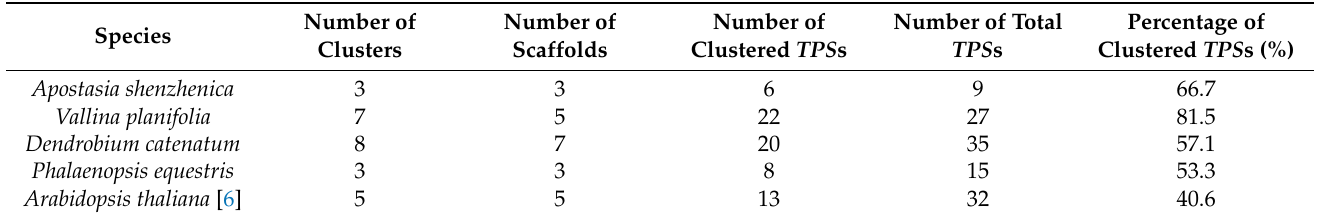
Table 3. The gene density of TPS s in the genome of Orchidaceae and other plant species. Species Genome Size (Mb)